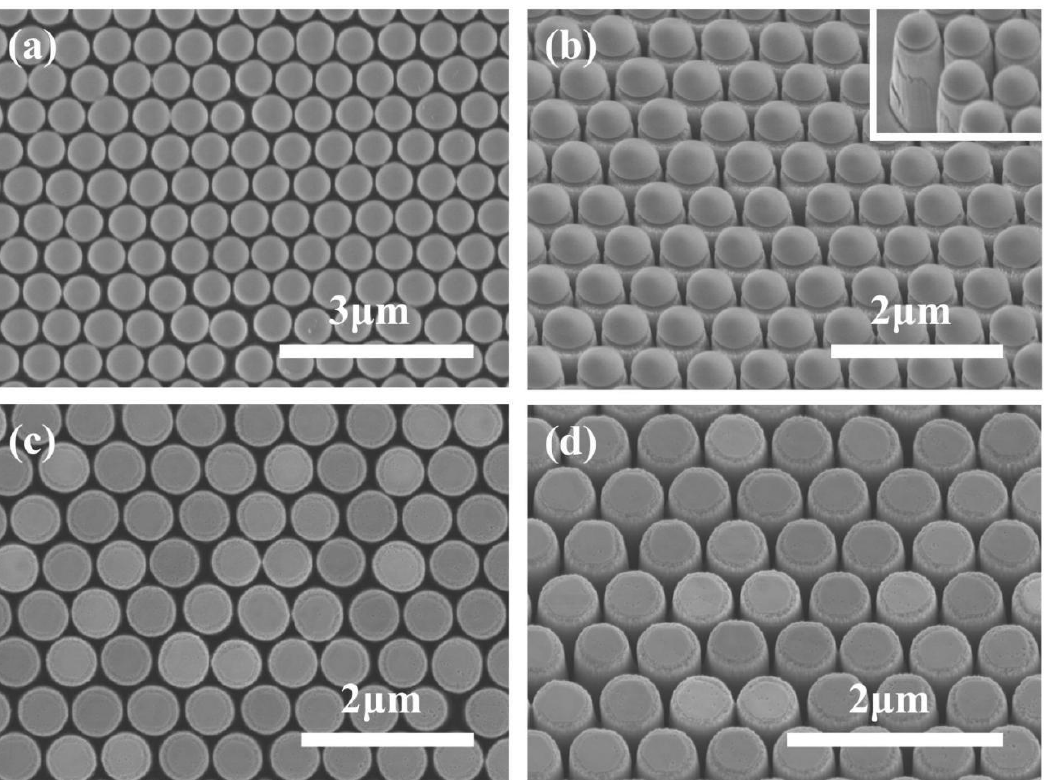
Figure 2. The SEM images of nanorod LED on β -Ga 2 O 3 substrate: the surface morphology of the ( a ) top view and ( b ) 25° tilted angle for the view before removing the SiO 2 nanospheres. The surface morphology of the ( c ) top view and ( d ) 25° tilted angle for the view after removing the SiO 2 nanospheres.